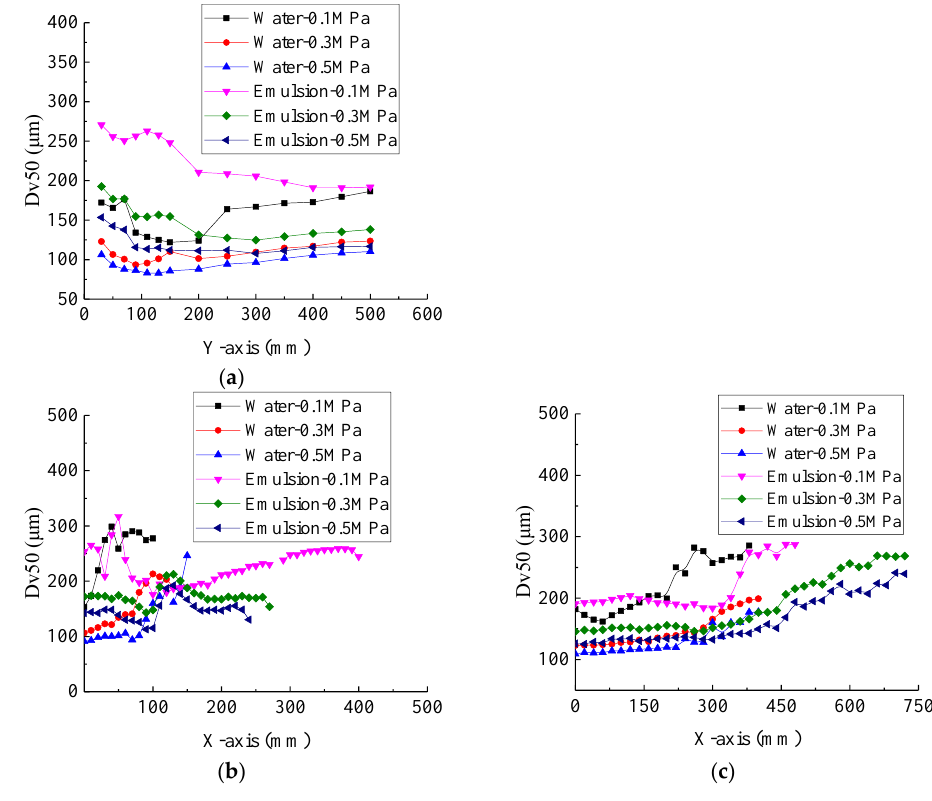
Figure 9. ( a ) Droplet size varieties with different distance nozzle outlet along Y-axis. ( b ) Droplet size varieties with different positions along X-axis at 50 mm distance from nozzle outlet. ( c ) Droplet size varieties with different positions along X-axis at 500 mm distance from nozzle outlet. The concentration of emulsion is